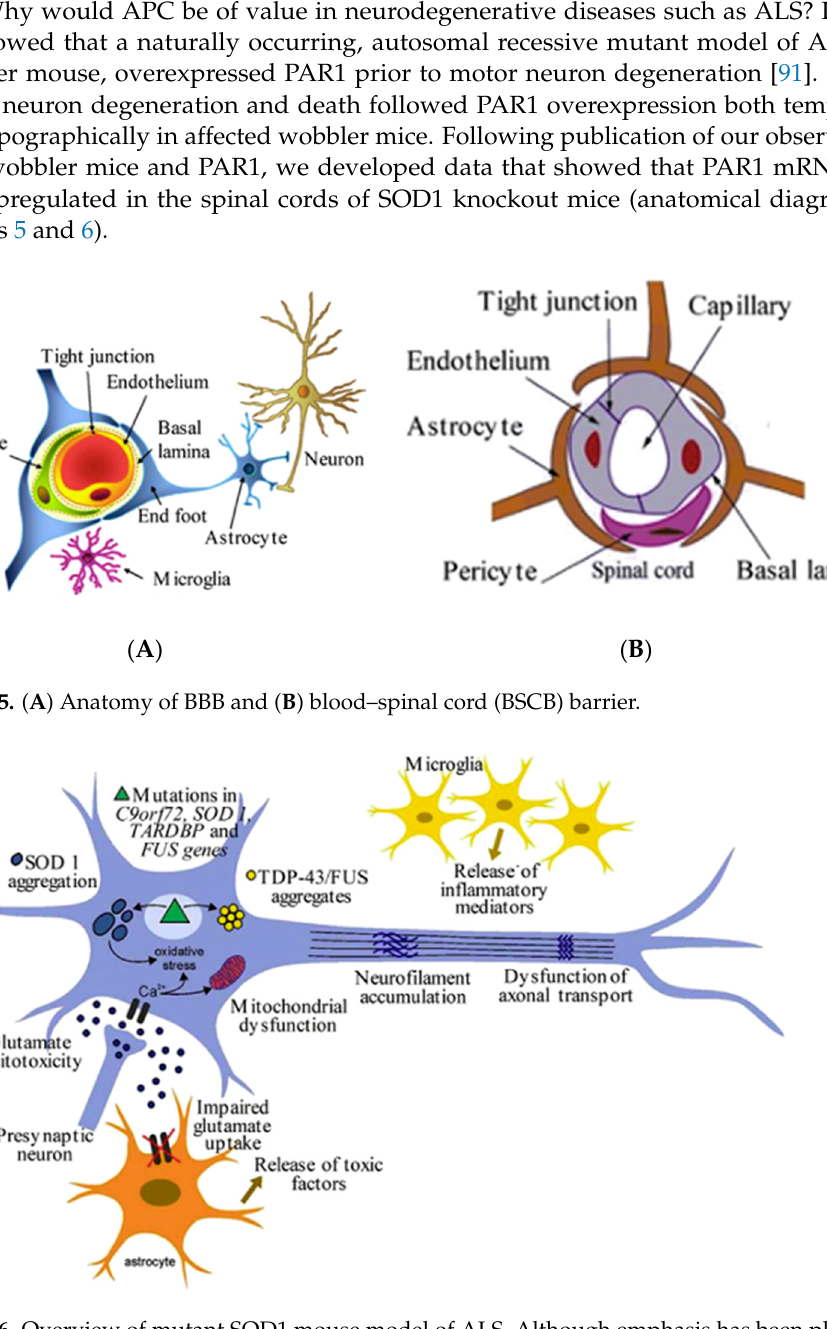
Figure 6. Overview of mutant SOD1 mouse model of ALS. Although emphasis has been placed on motor neuron degeneration, BBB dysfunction is also evident (as in Figure 5).